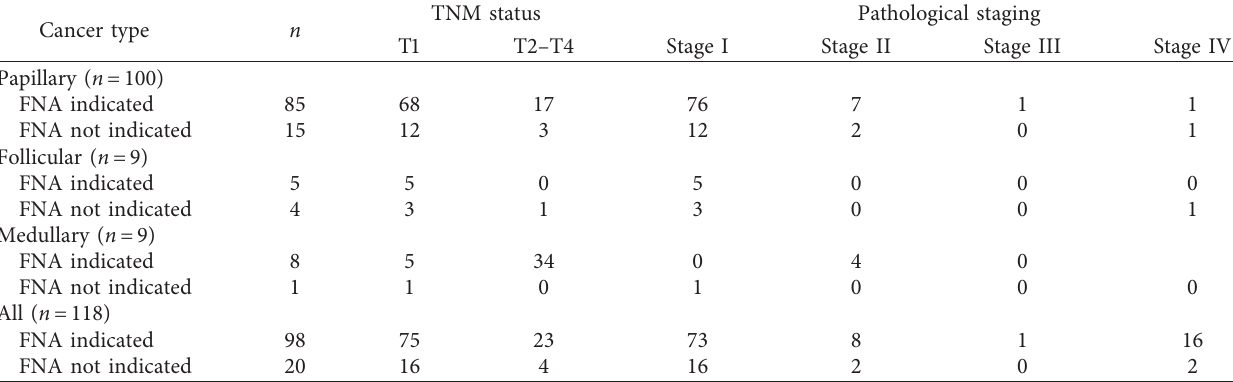
Table 5: EU-TIRADS score-based indication of FNA related to tumor stage in the 10–20mm size